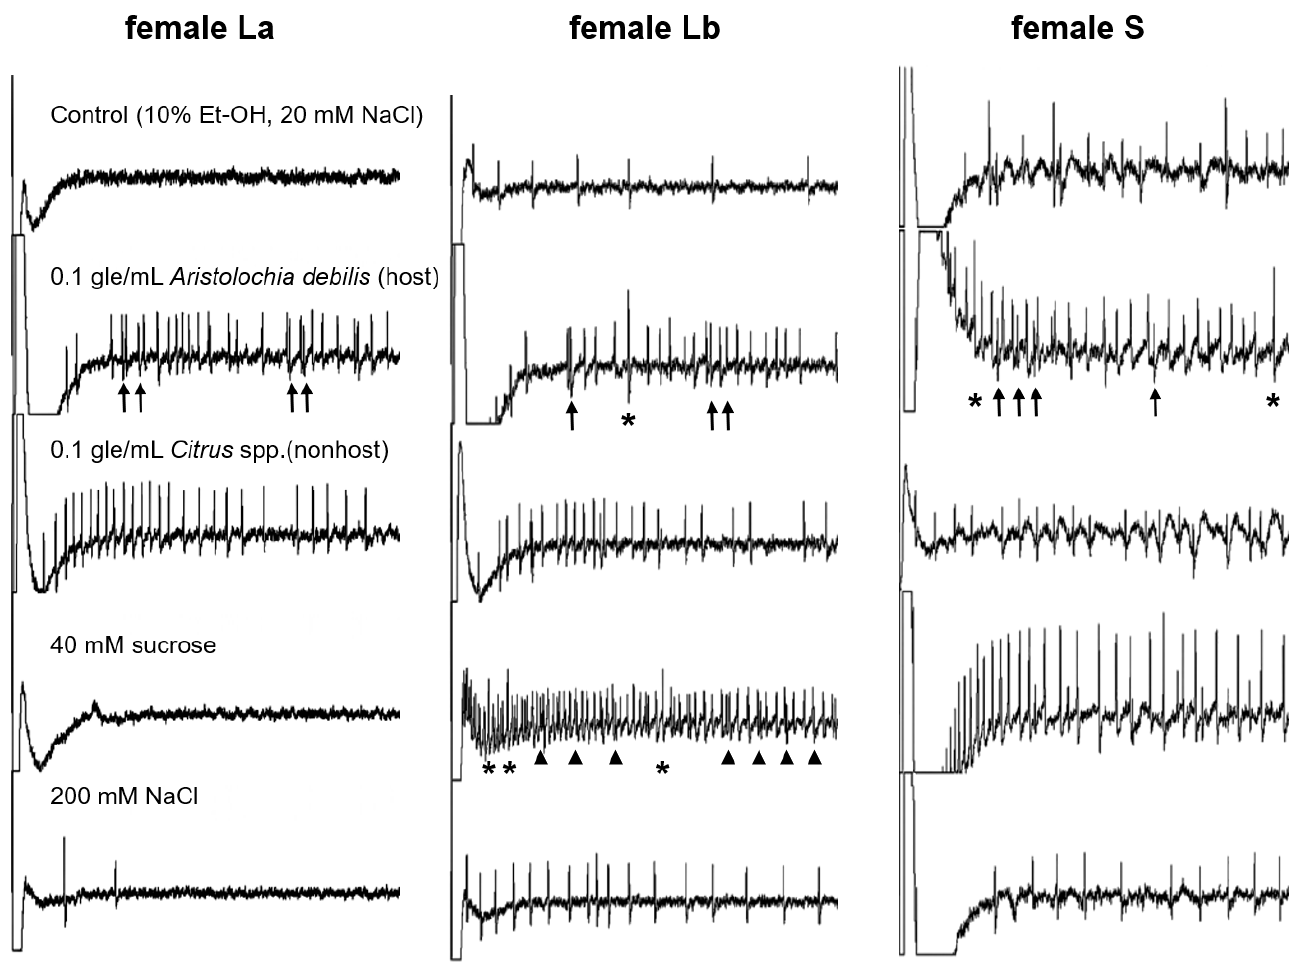
Figure 2. Electrophysiological responses to stimulants from the three types of female contact chemosensilla. Individual responses covered 0.5 s after stimulus onset. Stimulation with the extract of the host plant Aristolochia debilis caused one cell to fire at a constant rate and another (indicated by arrows) to fire irregularly and less frequently in all sensilla. Stimulation with sucrose caused one cell to fire at a constant rate and another (indicated by arrowheads) to fire irregularly and less frequently in long-type b sensilla. Asterisks indicate doublets of two spikes from two different cells. La: Long-type a sensilla; Lb: Long-type b sensilla; S: short-type sensilla. “gle/mL” indicates gram leaf equivalent in 1 mL of control